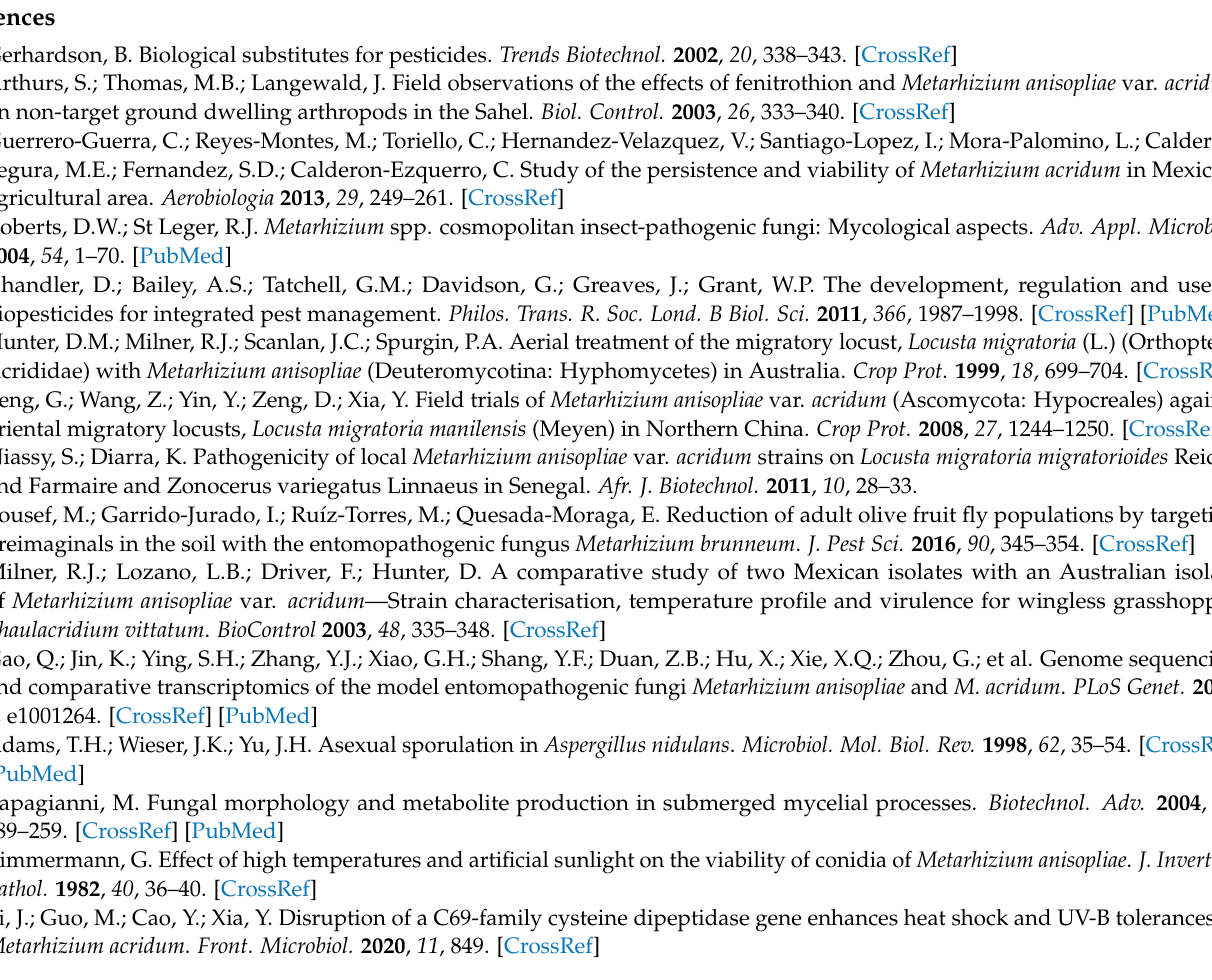
Table S1: Primers used in this study. Table S2: DGE data of ∆ MaAts vs. WT. Table S3: DEGs of ∆ MaAts vs. WT involved in stress tolerances and cell wall